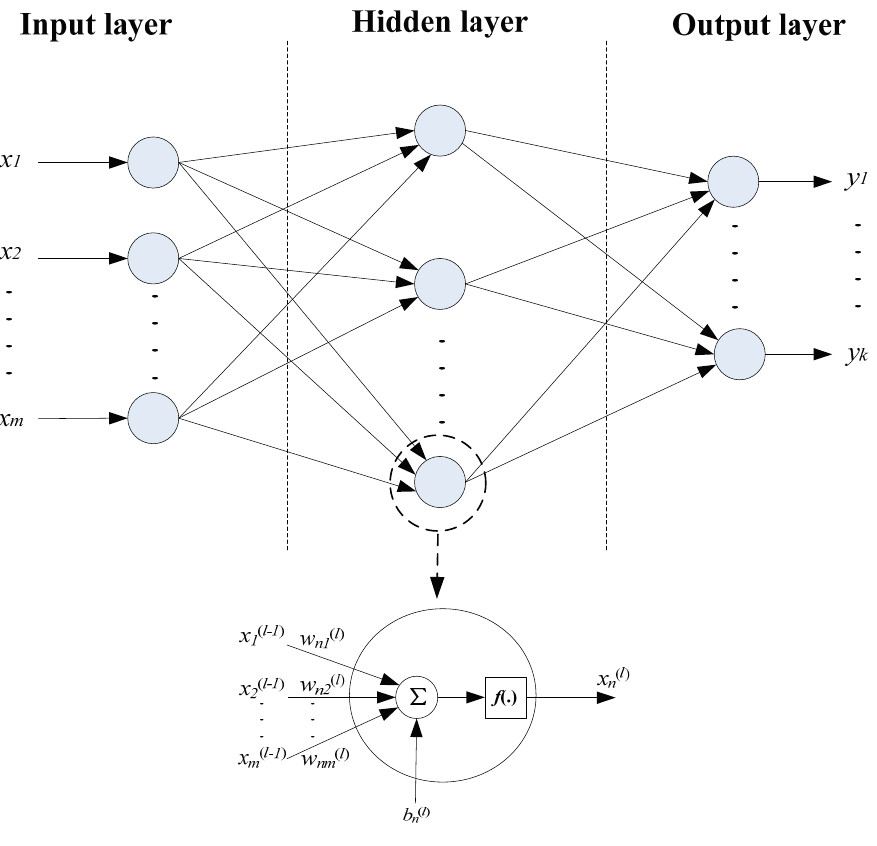
Figure 8. Schematic of a three-layer artificial neural